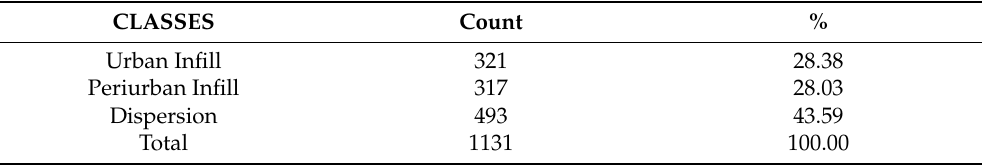
Table 8. Land consumption distribution between urban, periurban/suburban, and rural municipali- ties according to NDCL